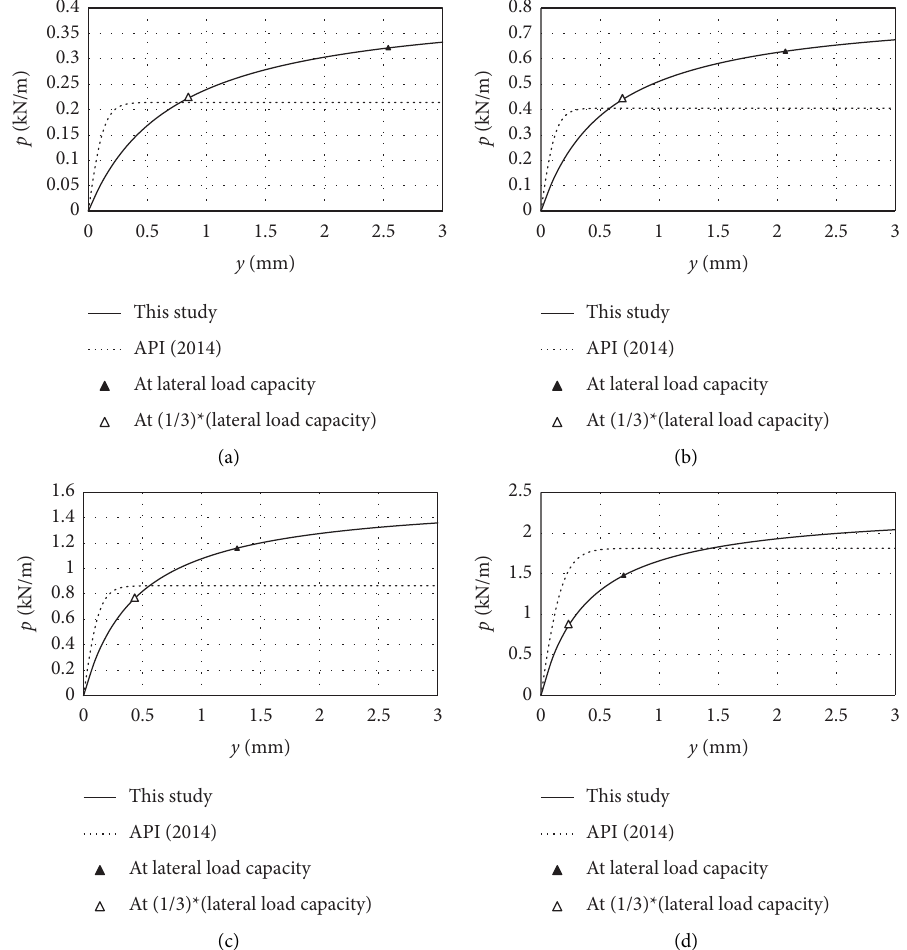
Figure 6: Comparison between experimental static p - y curves and API p - y curves (relative density of 70%): (a) 1 D , (b) 2 D , (c) 4 D , and (d) 6 D